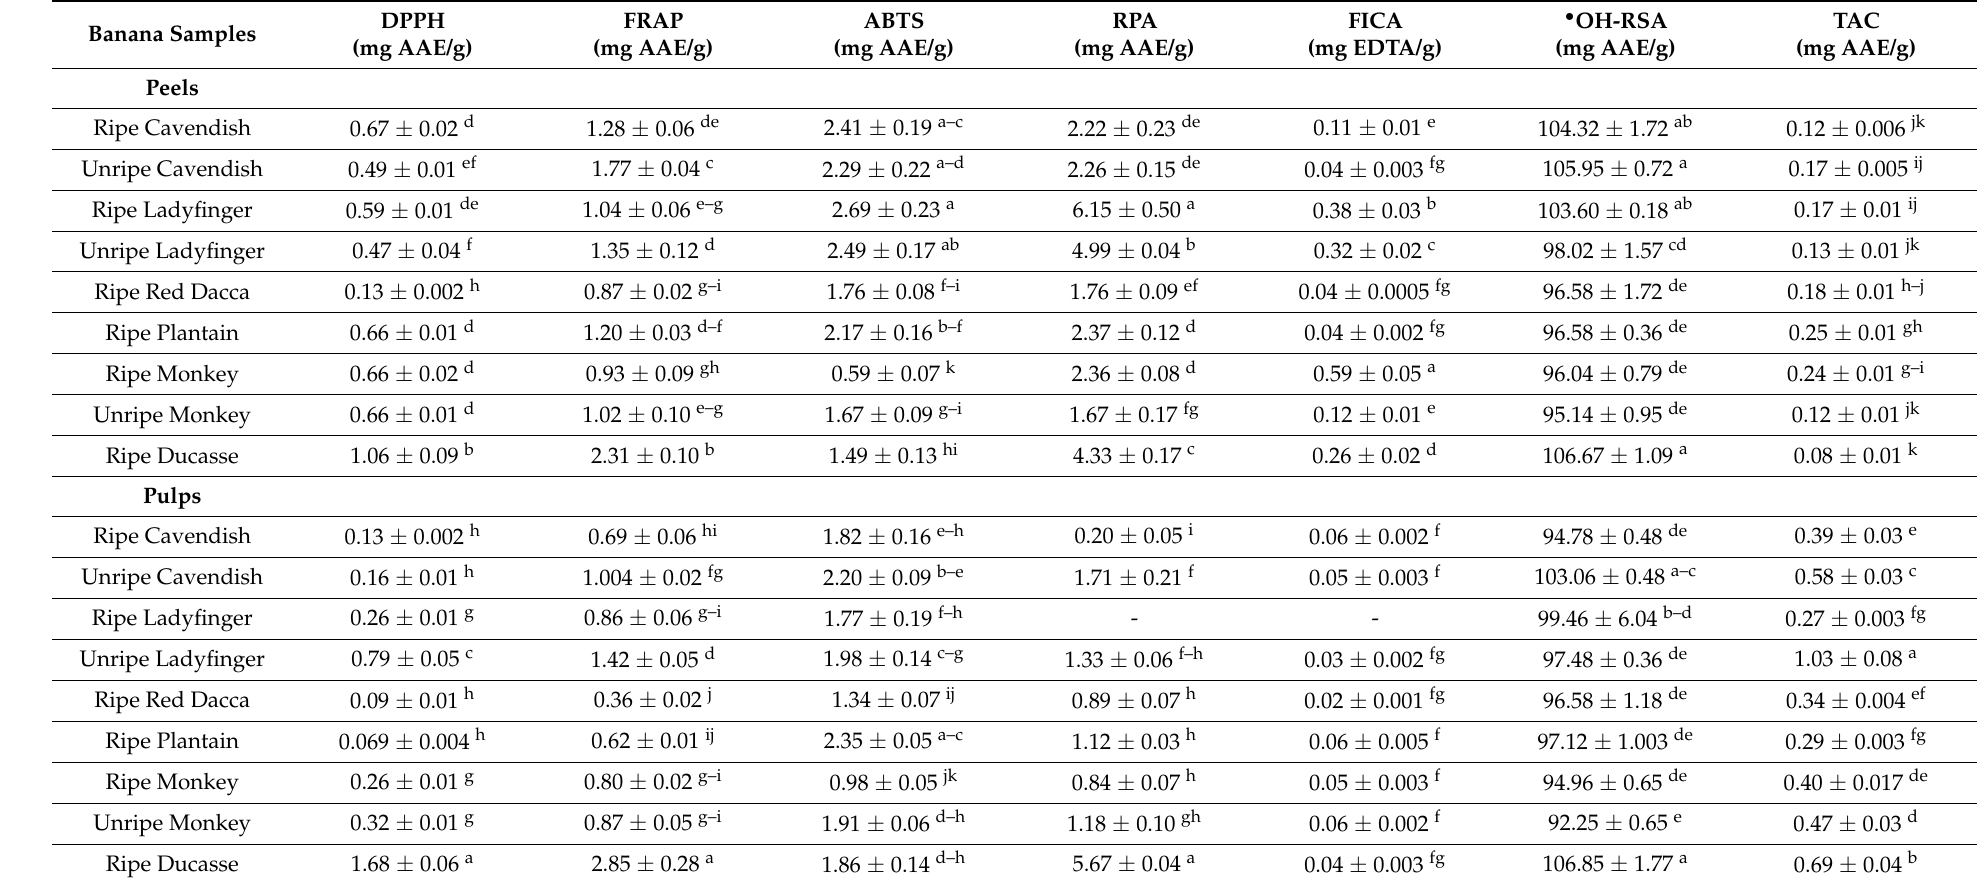
Table 2. Antioxidant activity of six Australian grown